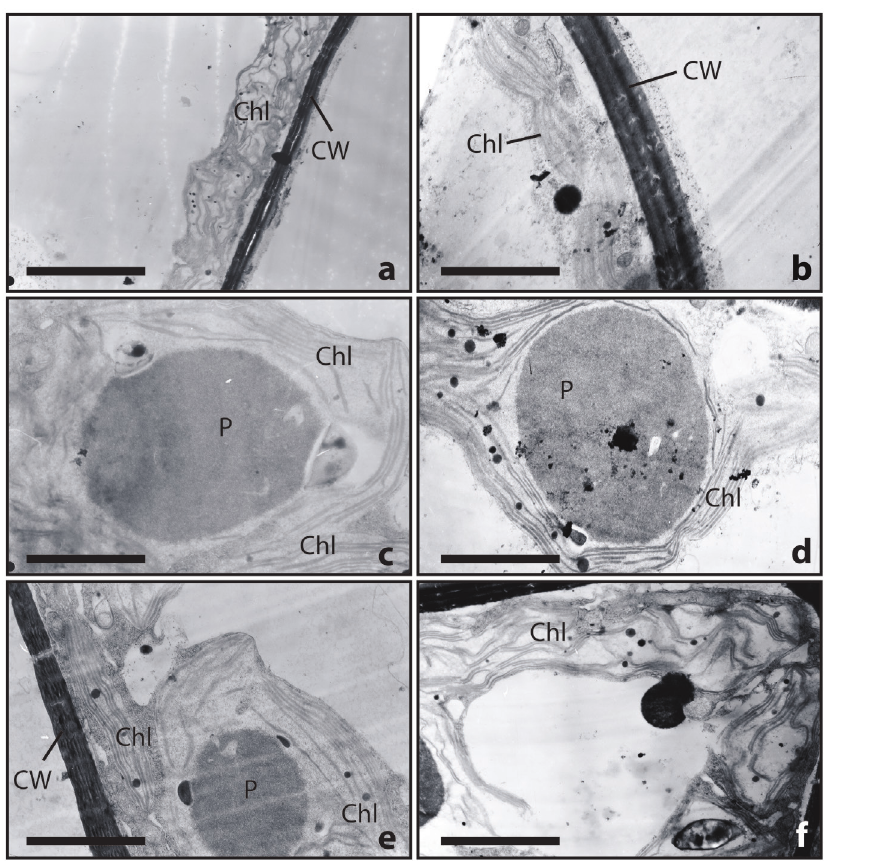
Figure 3: Ultrastructure analysis by transmission electron microscopy (TEM) of Cladophora glomerata with (right side) and without stress (left side): a – thin cell wall (CW) and normal chloroplast (Chl), b – multilayered cell walls (CW) and chloroplast (Chl); c, d – pyrenoid (P) surrounded by the chloroplast (Chl); e – multilayered cell wall (CW), chloroplast (Chl) and pyrenoid (P), f – cross section of filament showing chloroplast (Chl) (scale bar: 0.2